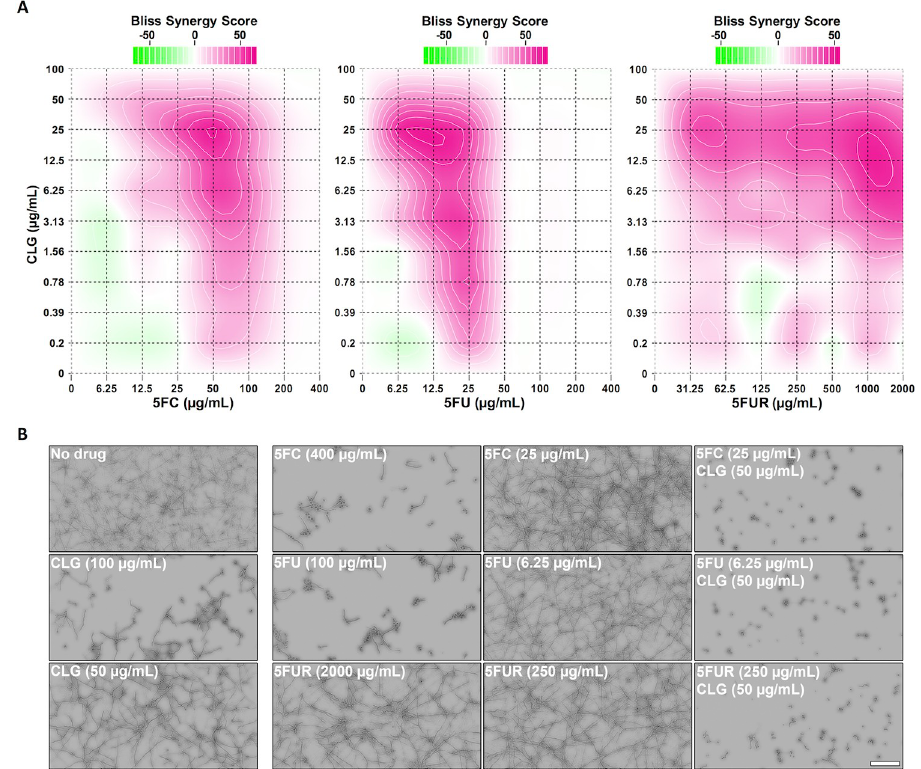
Fig 5. CLG potentiates 5FC, 5FU and 5FUR antifungal activity against A . fumigatus . (A) Checkerboard assays using 5FC, 5FU or 5FUR in combination with CLG were carried out to determine Bliss synergy scores (24 h). (B) Microscopic images of wells (48 h) corresponding to the visually detected MICs of each fluoropyrimidine and CLG in single use as well as their combination requiring the lowest 5FC, 5FU or 5FUR amounts to prevent fungal growth. Checkerboard assays were performed in RPMI medium. Scale bar: 100 μ